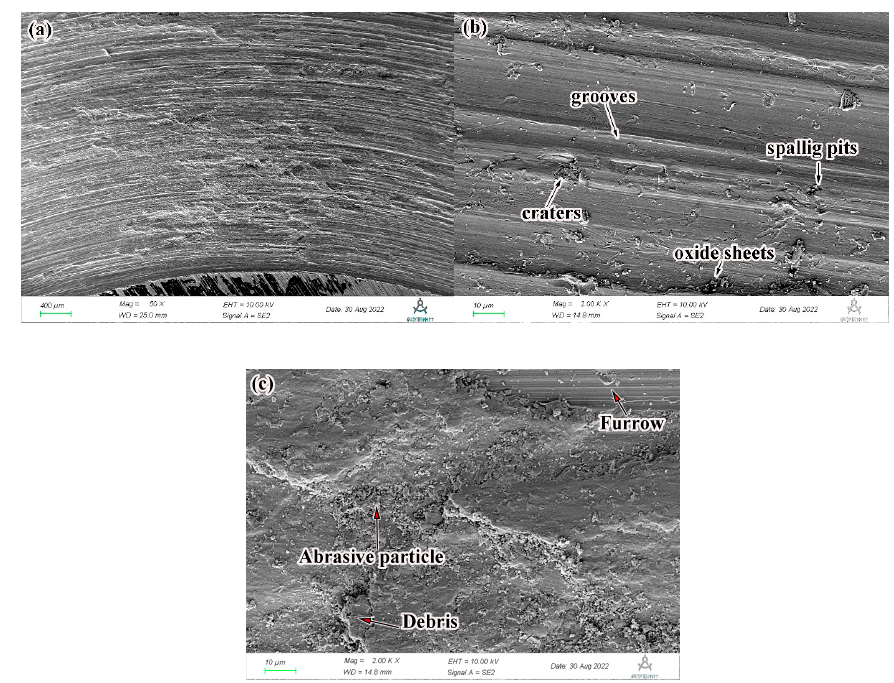
Figure 14. Friction and wear morphology: ( a ) wear morphology; ( b ) adhesive wear; ( c ) abrasive wear.